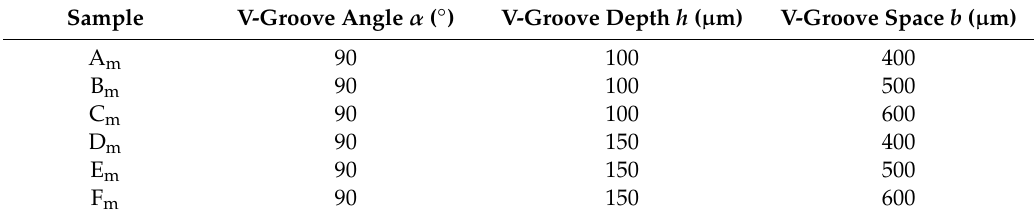
Table 2. The designed V-grooved structure parameters of mold cores.